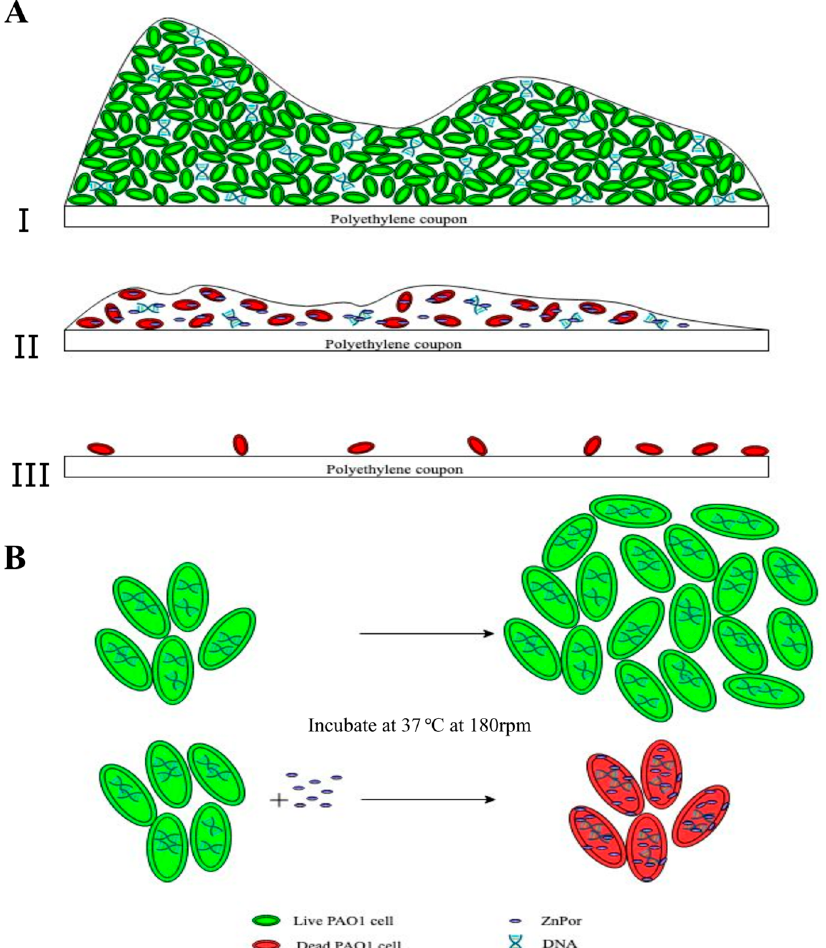
Figure 6. Proposed mechanism of action of ZnPor against PsA biofilms and individual cells. ( A.I ) The top panel represents a 16–18 h biofilm imaged after treatment with the LIVE/DEAD stain (as shown in Figure 2C control): a thick layer of cells encased in an extracellular matrix (ECM). All or almost all stained green with the LIVE/DEAD stain. The ECM contains a variety of different biomolecules, e.g., eDNA, which constitutes the majority of the ECM. ZnPor can diffuse throughout the ECM (as shown in Figure 2A) and thus interact with the eDNA in the matrix. ( A.II ) ZnPor treatment (prior to LIVE/DEAD) had the effect of destabilizing the biofilm, and ultimately, the biofilm sloughed off the surface ( II and III ). LIVE/DEAD-stained biofilms depict dead biofilm-associated cells left on the surface after ZnPor treatment. Overall, the matrices of biofilms treated with ZnPor were converted from thick and dense matrices to thin monolayers of almost exclusively dead cells, and the biofilms detached from the surfaces. ( B ) Individual planktonic PsA cells rapidly accumulated ZnPor in the cytoplasm and membrane/cell wall (Figure 3A). We hypothesize that ZnPor in the cytoplasm binds to the chromosomal DNA and inhibits replication. As shown in Figure 4A, ZnPor-treated cells did not increase in total number (nor did they decrease); these cells did not form colonies when plated onto LB agar plates and thus were not viable (Figure 4B). However, the cells did not lyse, as indicated in Figure 4C.